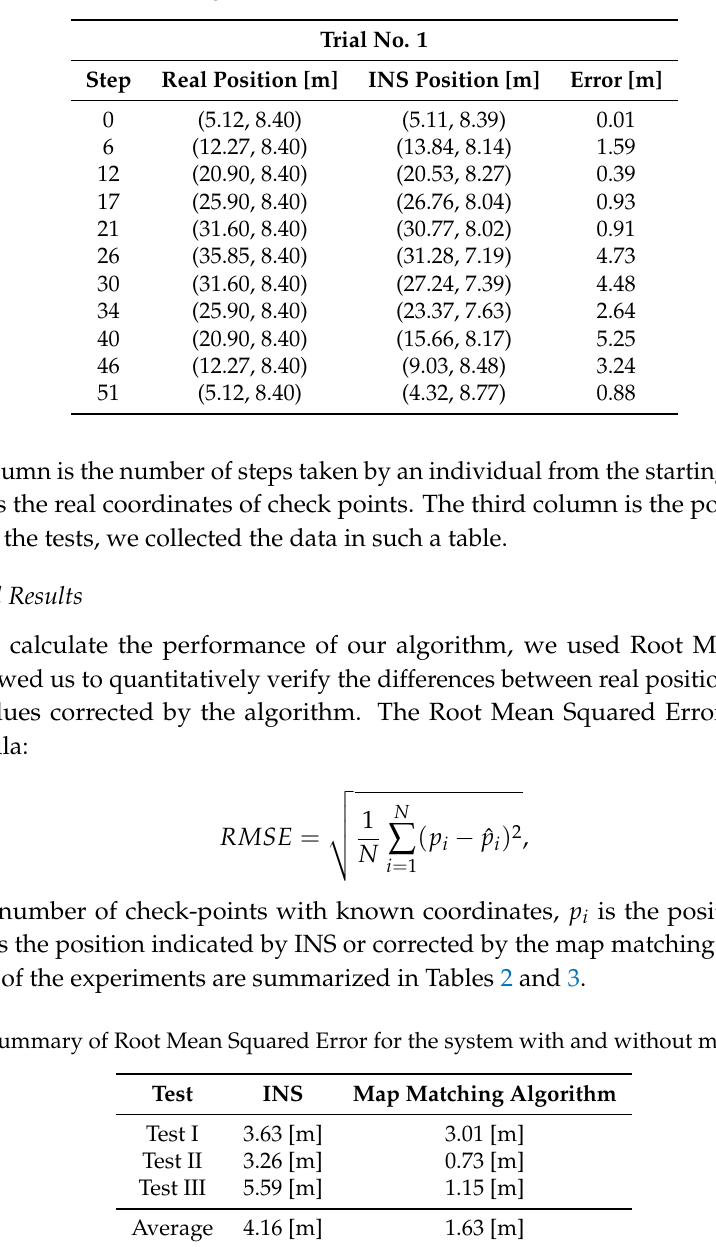
Table 1. Summary of data from an exemplary test. The position of the agent is relative to (0, 0) point, placed in the corner of the building.